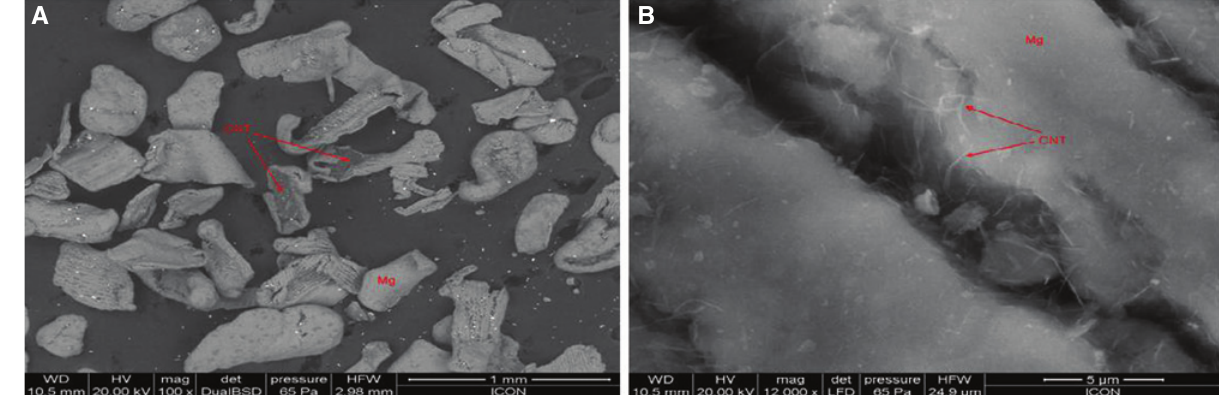
Figure 2 SEM images of ball-milled powder.